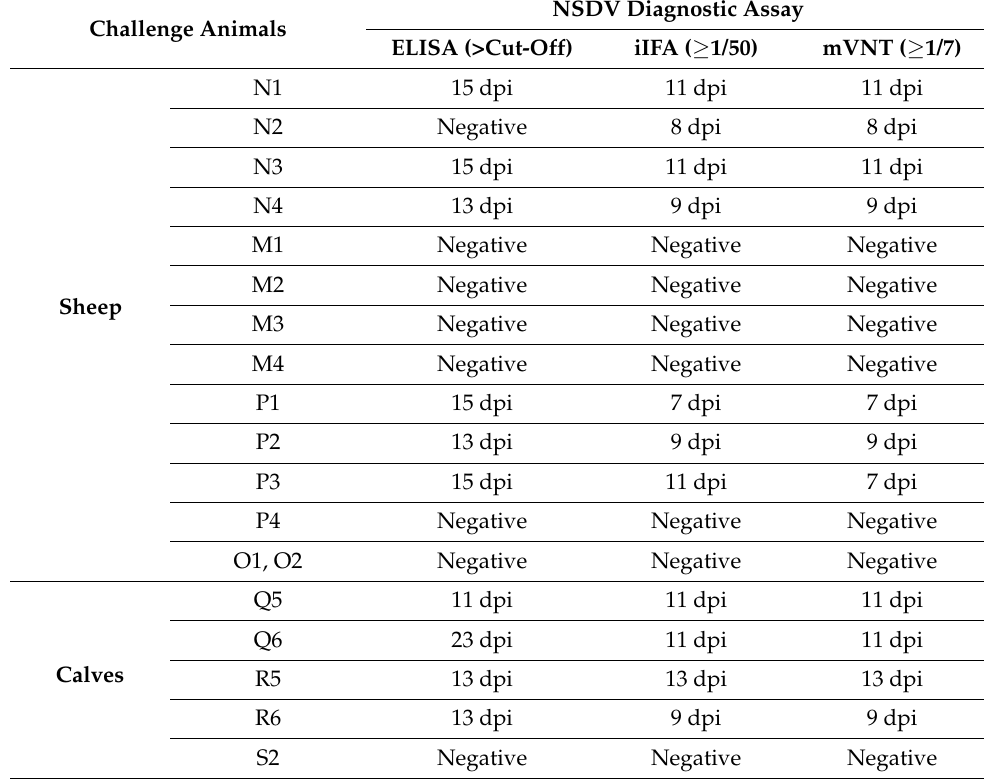
Table 4. Comparison of first detection of NSDV antibodies by individual